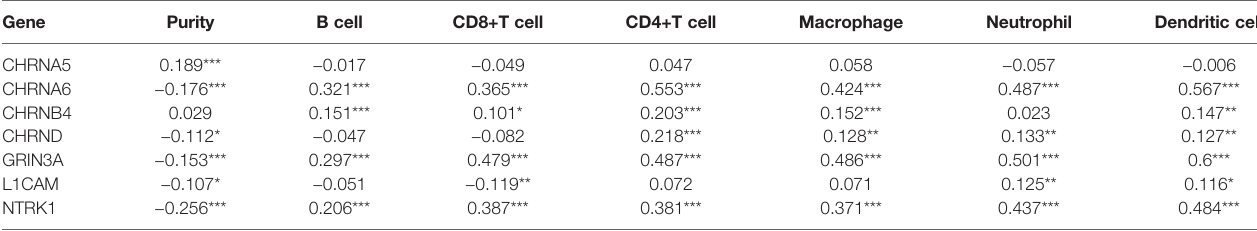
TABLE 1 | The association between seven prognostic NCCGs and immune in fi